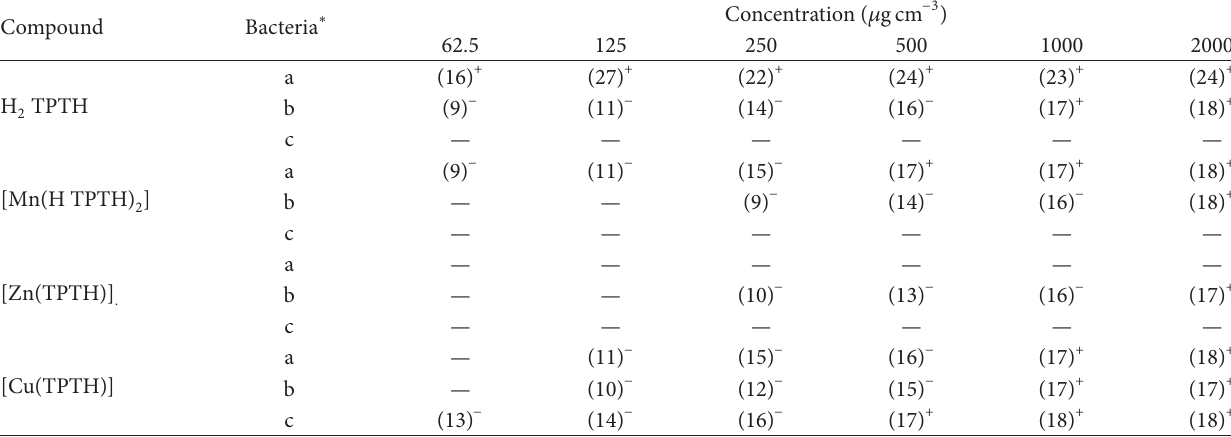
, over the parentheses indicate the zone of inhibition and no TPTH and its 2